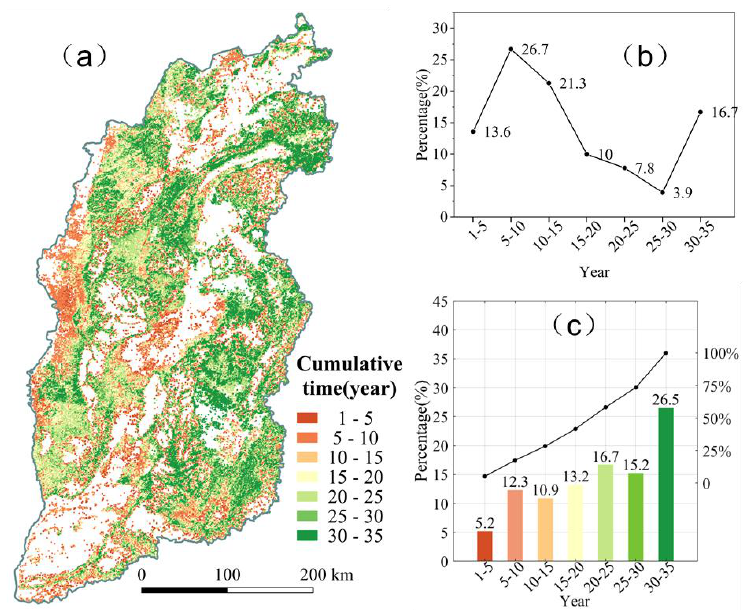
Figure 4. The spatial and temporal distribution of the change processes: ( a ) spatial distribution of restoration; ( b ) the statistics of duration of restoration subsequences; ( c ) the statistics of cumulative time of restoration.